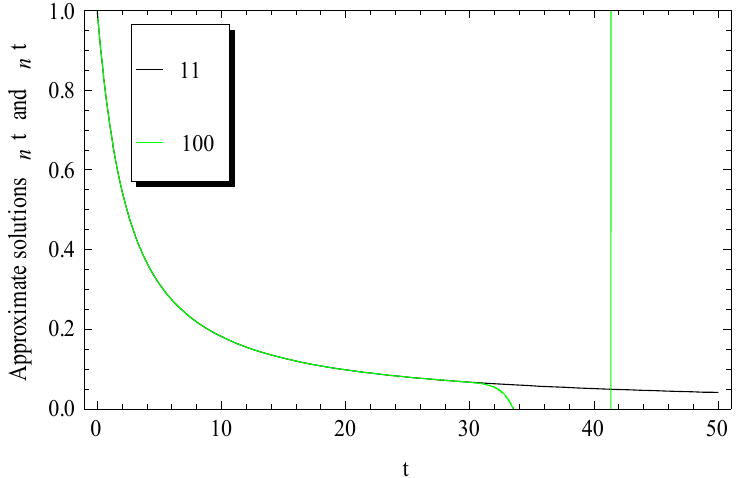
Figure 5. Comparison between the Adomian approximate solutions and power series solution at 1 =λ and 6.1 = q .